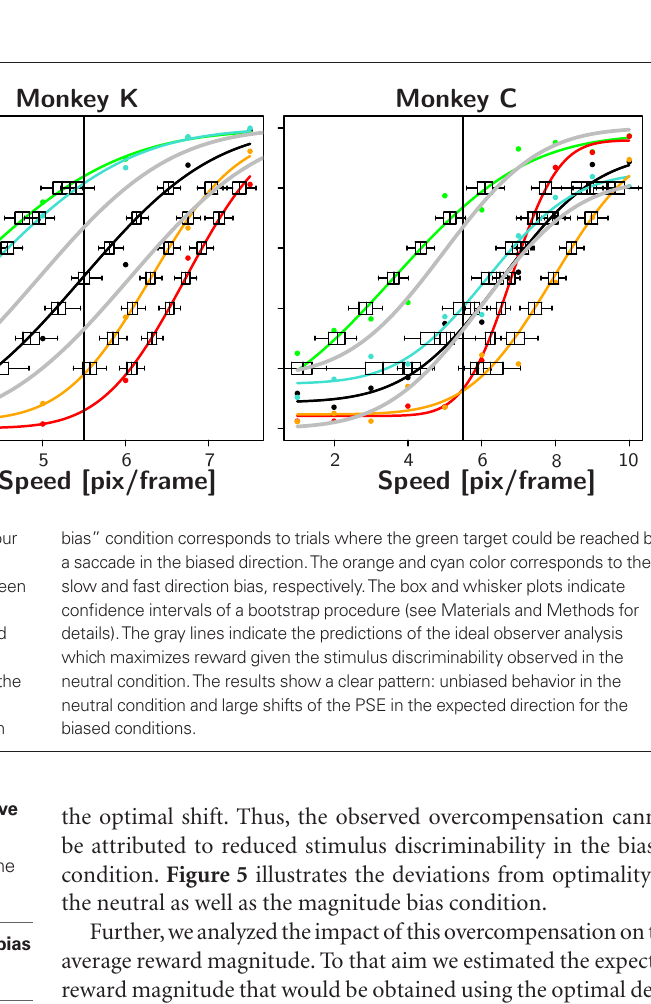
Table 2 | Fraction of actual and optimal reward volume that could have been earned with the optimal decision criterion. Especially in the magnitude bias condition monkeys loose a considerable amount due to the suboptimal integration of sensory and non-sensory information.